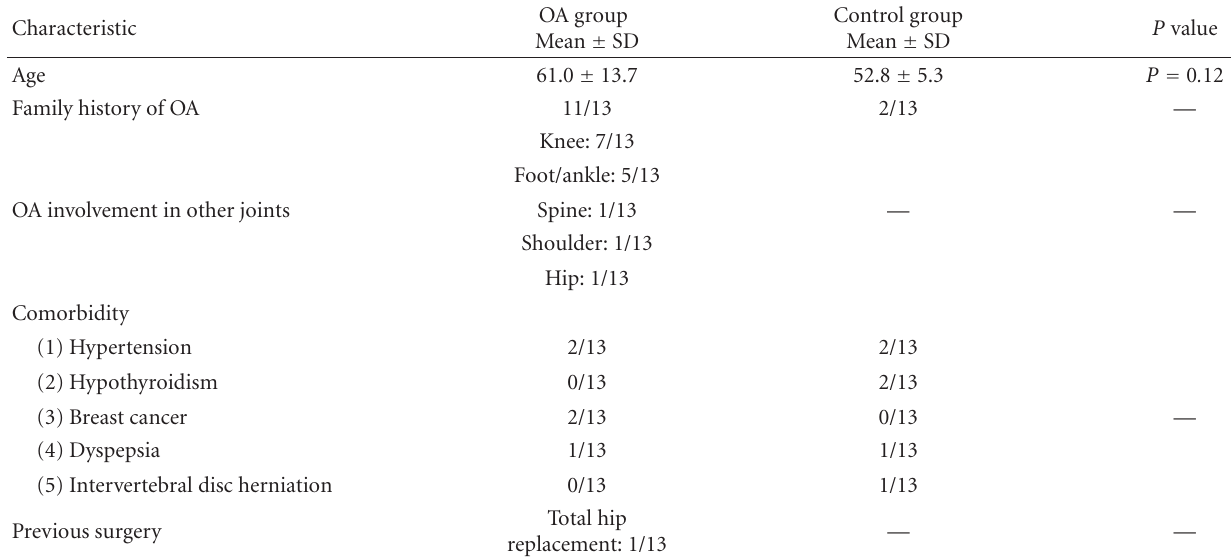
Table 1: Group demographics. The age (mean ± SD), family history of OA, comorbidity, and information on previous joint replacement surgery in the hand OA and control groups are